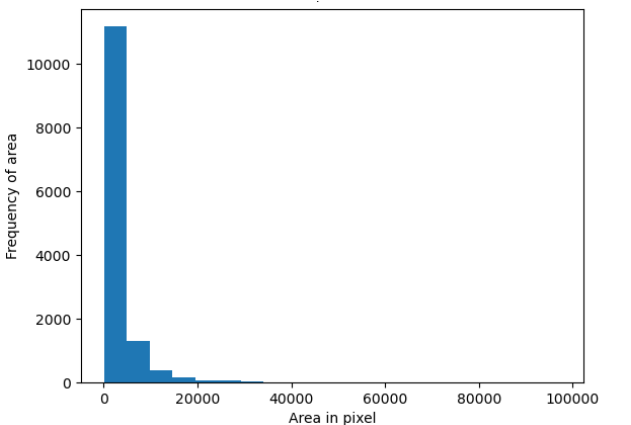
Figure 7. Statistical chart of the data sample